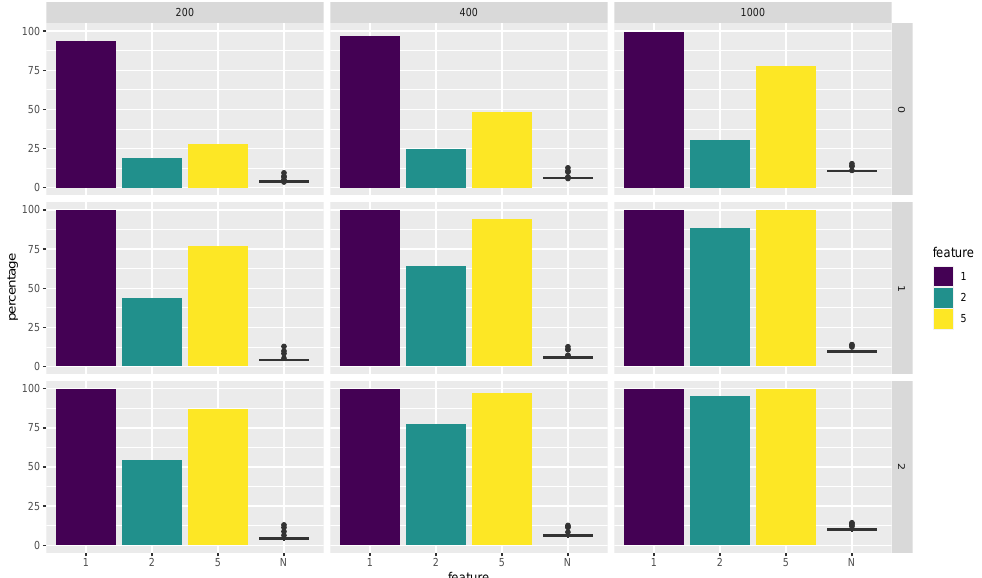
Figure 2. The average selected proportion for each feature for different sample sizes (corresponding to each column) and iteration number (corresponding to each row) in Model 1